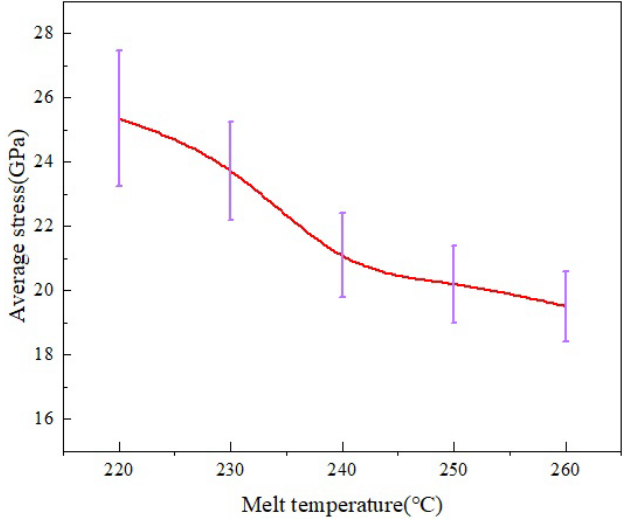
Figure 22. Average stress distribution at different melt temperatures in the MD simulation.